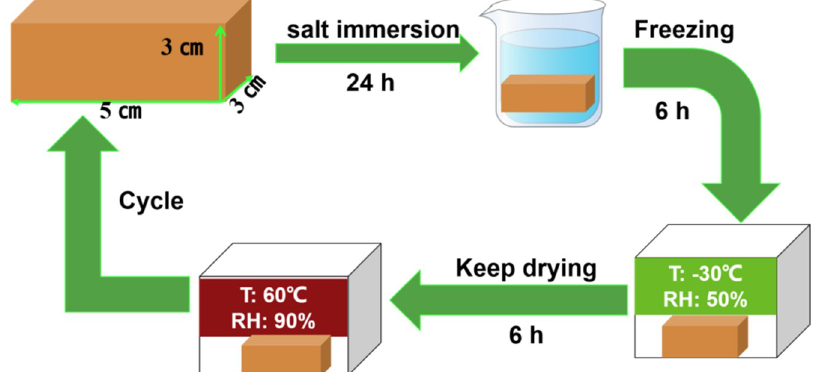
Figure 3. Weather resistance cycle steps.